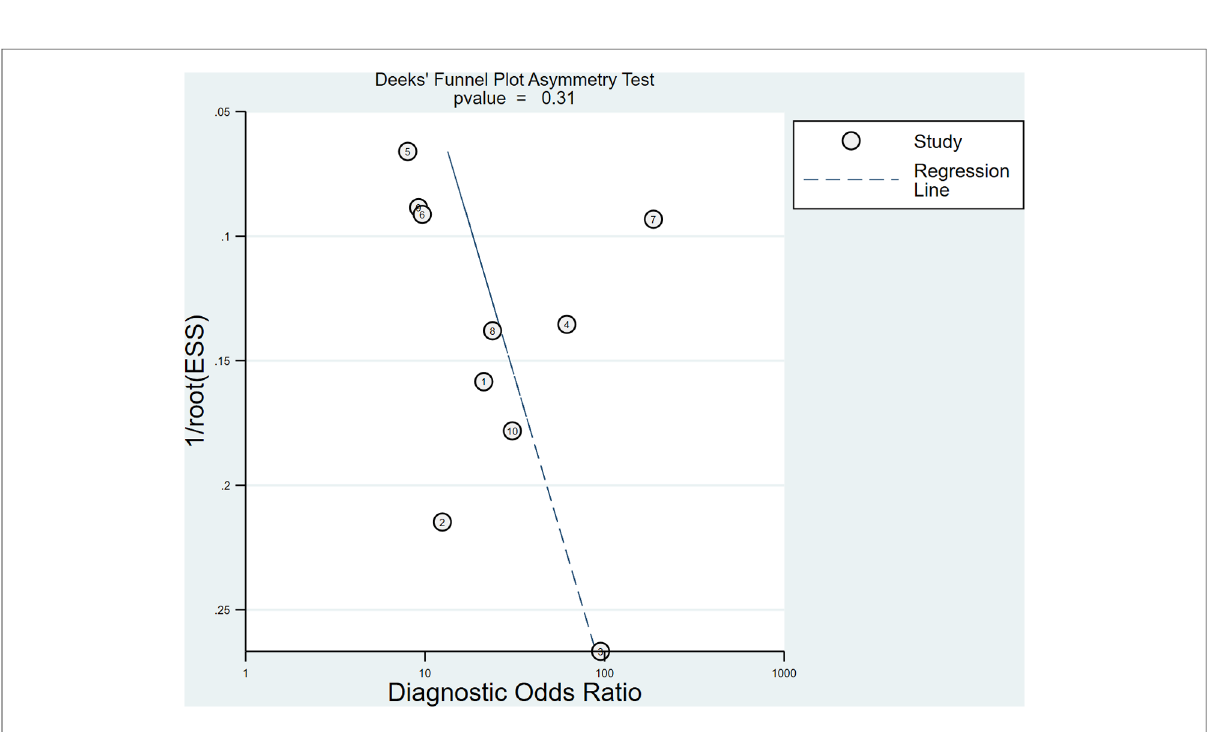
Figure 9 Funnel plot of CT for the diagnosis of